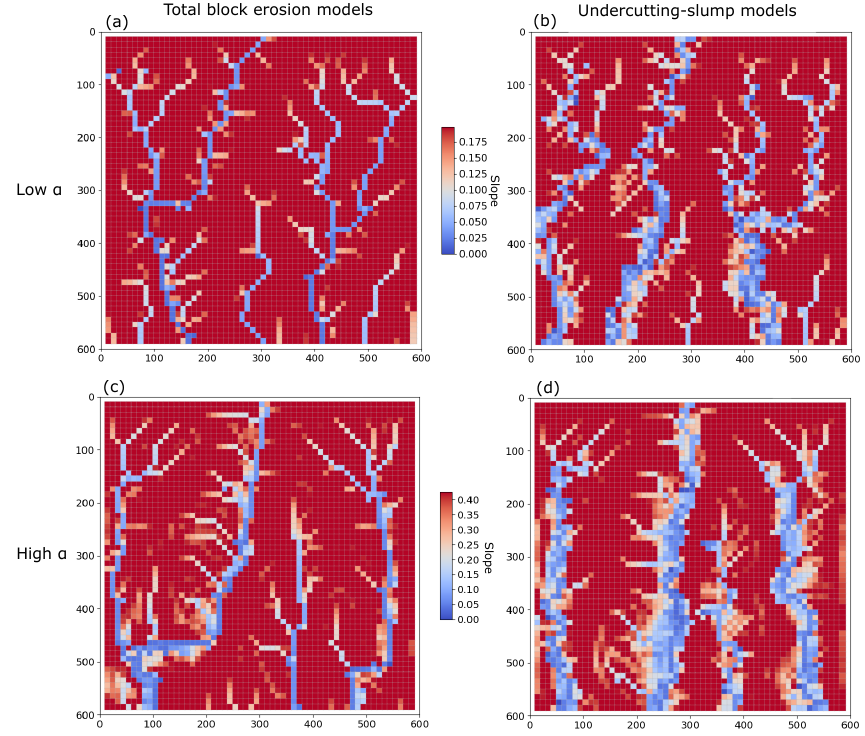
Figure 6. Slope maps showing fluvially carved valleys in total block erosion and undercutting-slump models with high and low values of α . The white and blue areas in the maps indicate slopes that are characteristic of fluvial channels, i.e., lower than the reference slope value (Eq. 17). (a) Total block erosion model, low α (detachment limited). (b) Undercutting-slump model, low α (detachment limited). (c) Total block erosion model, high α (transport limited). (d) Undercutting-slump model, high α (transport